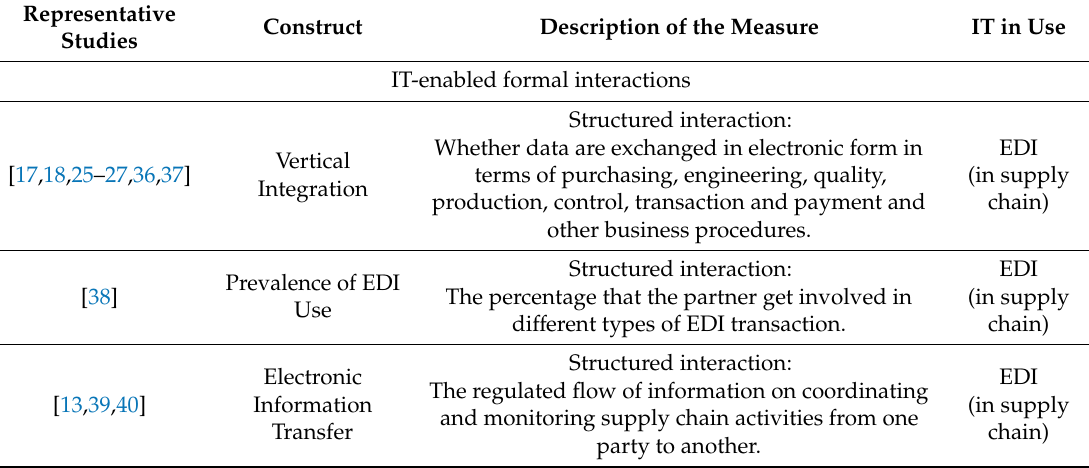
Table 1. Construct and Measurement of information-technology (IT)-enabled